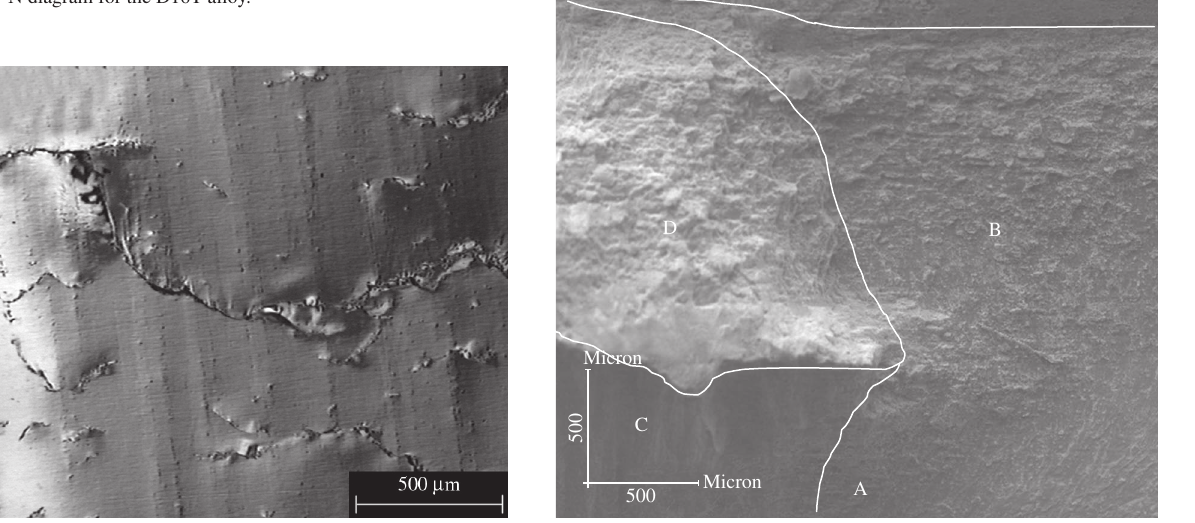
Figure 7. S–N diagram for the D16T